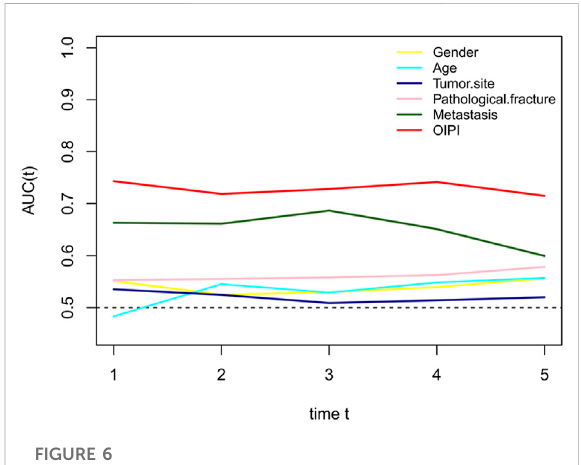
FIGURE 6 ComparisonofthepredictiveeffectbetweenOIPIandclinical characters on OS. A larger AUC in the t-ROC means a better predictive ability. OIPI, osteosarcoma immune prognostic